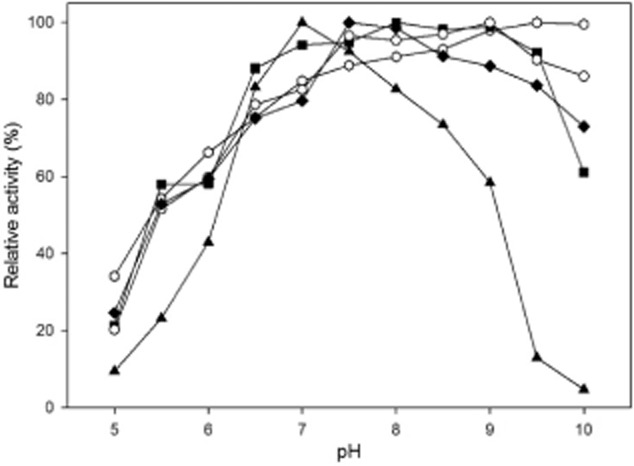
Effect of pH on activities of Udhs from A. tumefaciens, F. pelagi, O. granulosus, S. viridochromogenes and P. syringae presented as relative activities. Hexagon, F. pelagi UDH; Squares, A. tumefaciens UDH; Triangles, O. granulosus UDH; Circles, S. viridochromogenes UDH; Diamonds, P. syringae UDH.